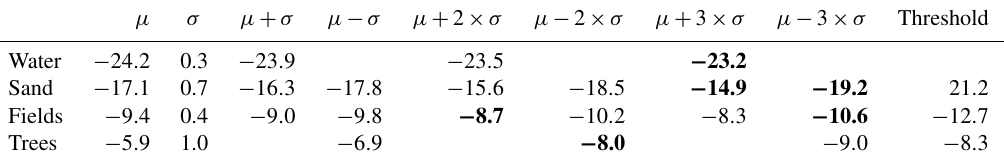
Table B2. Determination of thresholds for a sampling duration of 1 month and a 7 × 7 boxcar filter. Values in bold are those that have been used to calculate the threshold indicated in the last column. All values are in decibels (dB). µ – mean. σ – standard deviation.